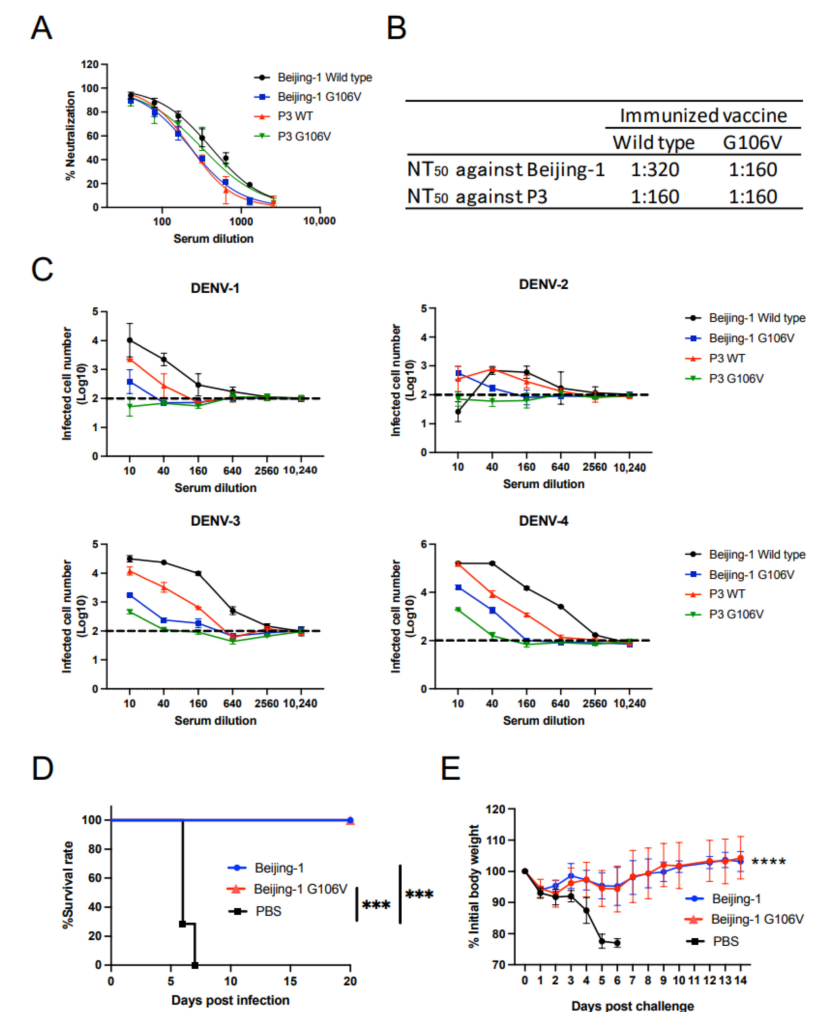
Figure 5. Effect of G106V mutation on JEV vaccine strains. ( A ) Neutralizing activity against JEV. ( B ) NT 50 values against JEV. NT 50 is calculated as a maximum serum dilution yielding >50% neu- tralization. ( C ) ADE activity against four serotypes of DENV. Dotted lines indicate the baseline of infected cells in control (100 infected cells; log 10 2.0). Complement was not added to this assay. ( D ) Survival of vaccine-administered mice after JEV challenge. A group of six BALB/c mice was infected with 70 LD 50 of the JEV P3 strain. Statistical significance was analyzed using a log-rank test. *** p < 0.001 for the comparison between vaccinated and unvaccinated mice. ( E ) Body weight change in mice after JEV challenge. Statistical significance was analyzed using repeated measures two-way analysis of variance. **** p < 0.0001 for the comparison between vaccinated and unvaccinated